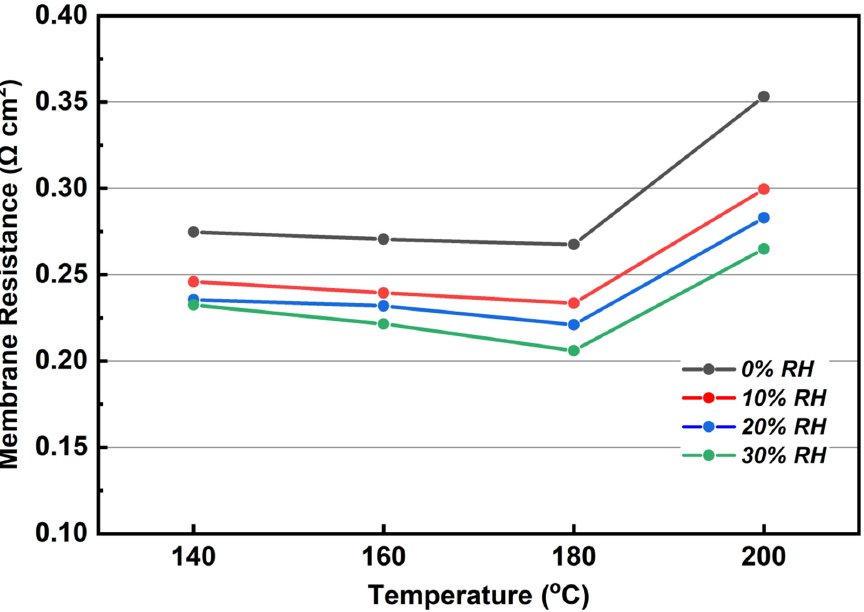
Figure 11. R m for different RH at the anode with 20 mA cm − 2 of output constant DC density under 0% RH gas conditions (140 to 200 °C, equal H 2 and O 2 flow rates at 0.4 L min − 1 ).